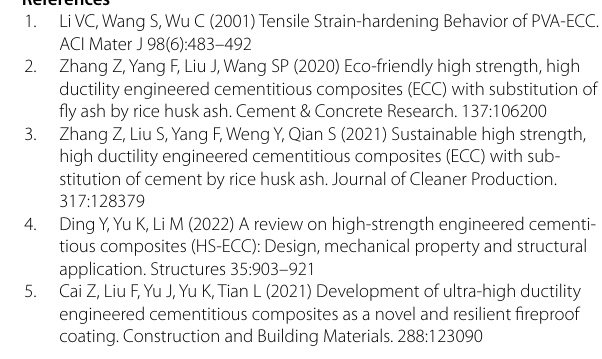
Table 3 The calculated J Mixtures